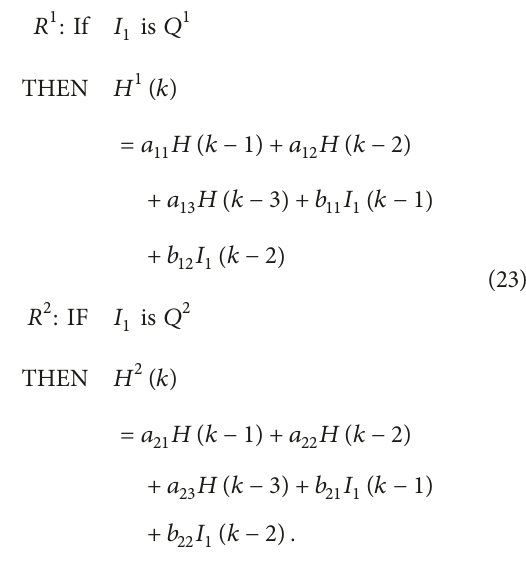
Figure 3: The surge tank